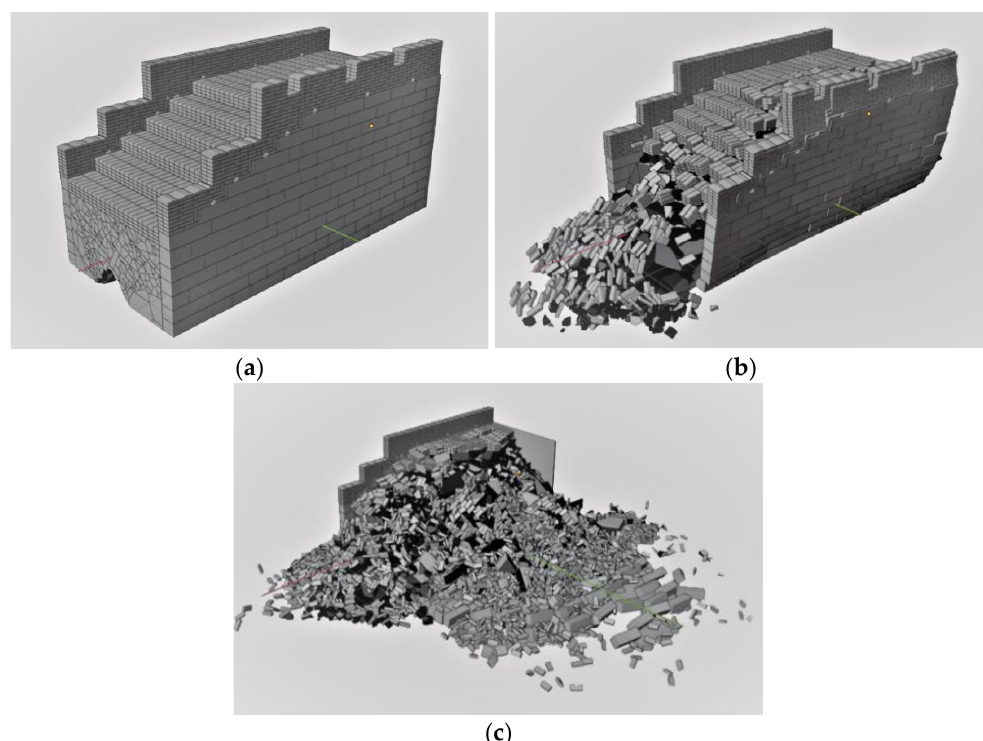
Figure 20. Steps collapse in a sloped section: ( a ) Initial; ( b ) In process; ( c ) Final.